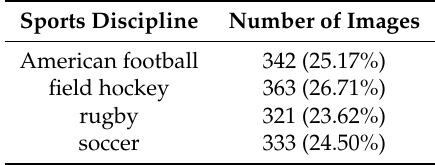
Table 1. The basic information about sports image